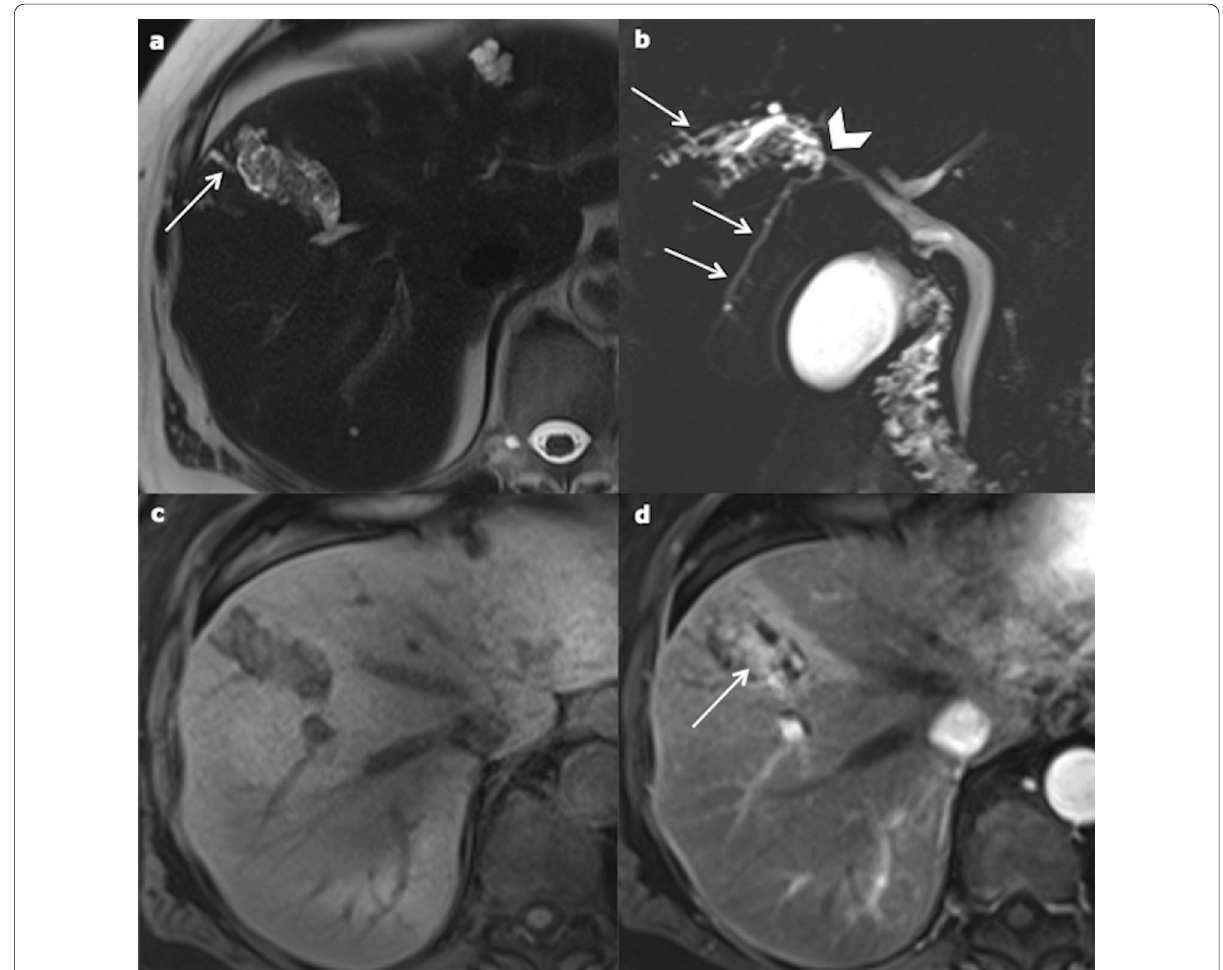
Fig. 21 Intraductal papillary neoplasm of the bile duct in a 67-year-old female. a Axial T2-weighted magnetic resonance imaging displays intraductal heterogeneous cystic and tissular mass (star) with dilated bile duct in contact (arrows). The cystic part of the mass is better seen at magnetic resonance cholangiopancreatography ( b ), and so are the upstream biliary dilatation (arrows) and the connection to the biliary tree (arrowhead). c and d Axial T1-weighted non-enhanced magnetic resonance imaging on arterial phase shows a highly enhanced tissular